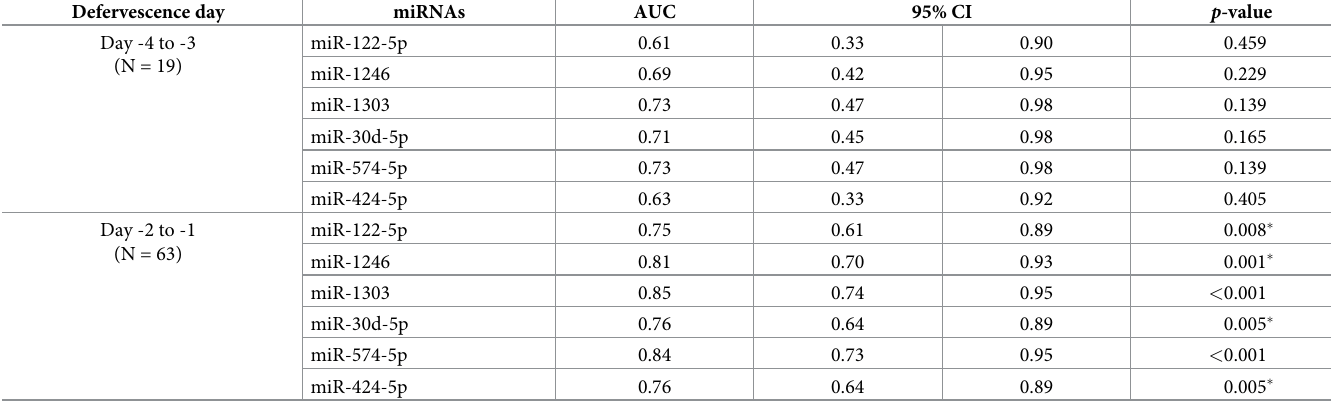
Table 2. Receiver operator characteristics (ROC) curves comparing the predictive accuracy of serum miRNAs for predicting severe dengue on different disease days. Defervescence day miRNAs Day -4 to -3 (N = 19)